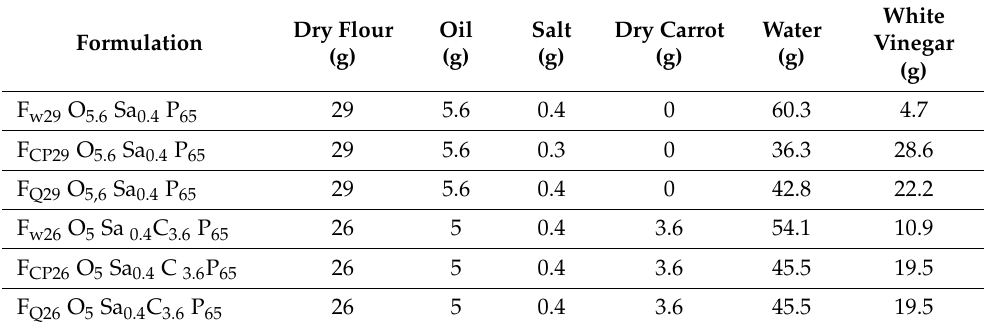
Table 2. Formulations of the different acidified sponge cake batters with and without carrots. Dry Flour Formulation (g)